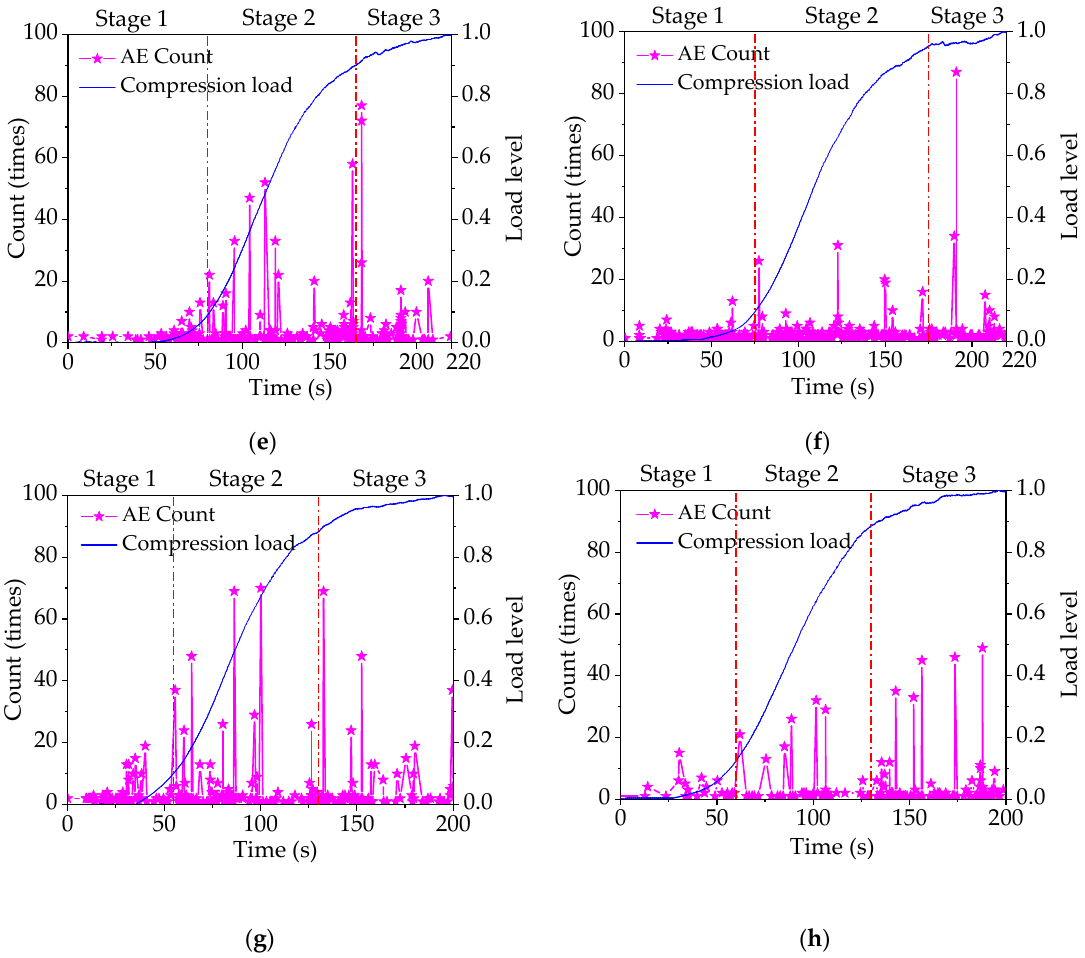
Figure 7. The AE count and load level versus time during compression at 50 °C for SBS-modified asphalt mixture with basalt fiber under various F-T cycles. ( a ) 0 F-T cycle; ( b ) 3 F-T cycles; ( c ) 6 F-T cycles; ( d ) 9 F-T cycles; ( e ) 12 F-T cycles; ( f ) 15 F-T cycles; ( g ) 18 F-T cycles; and ( h ) 21 F-T